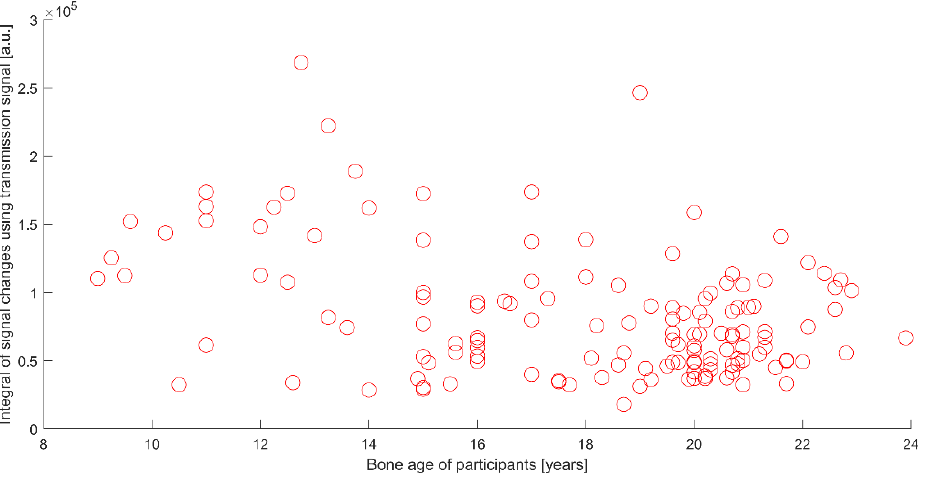
motion (y ‐ axis) in relation to subject bone age (x ‐ axis) using the most distal transducer element. motion (y-axis) in relation to subject bone age (x-axis) using the most distal transducer element. Each Each circle represents a single individual. circle represents a single